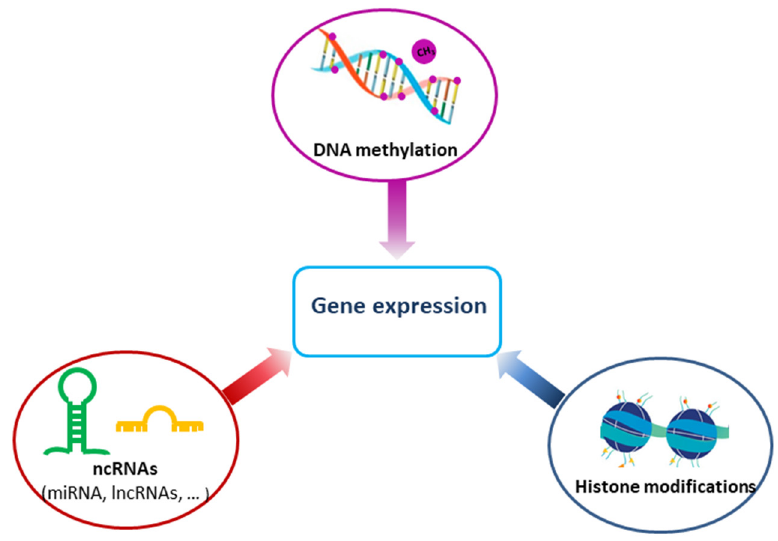
Figure 2. Epigenetic mechanisms contributing to gene regulation, DNA methylation, histone modifications, and noncoding RNAs (ncRNAs).